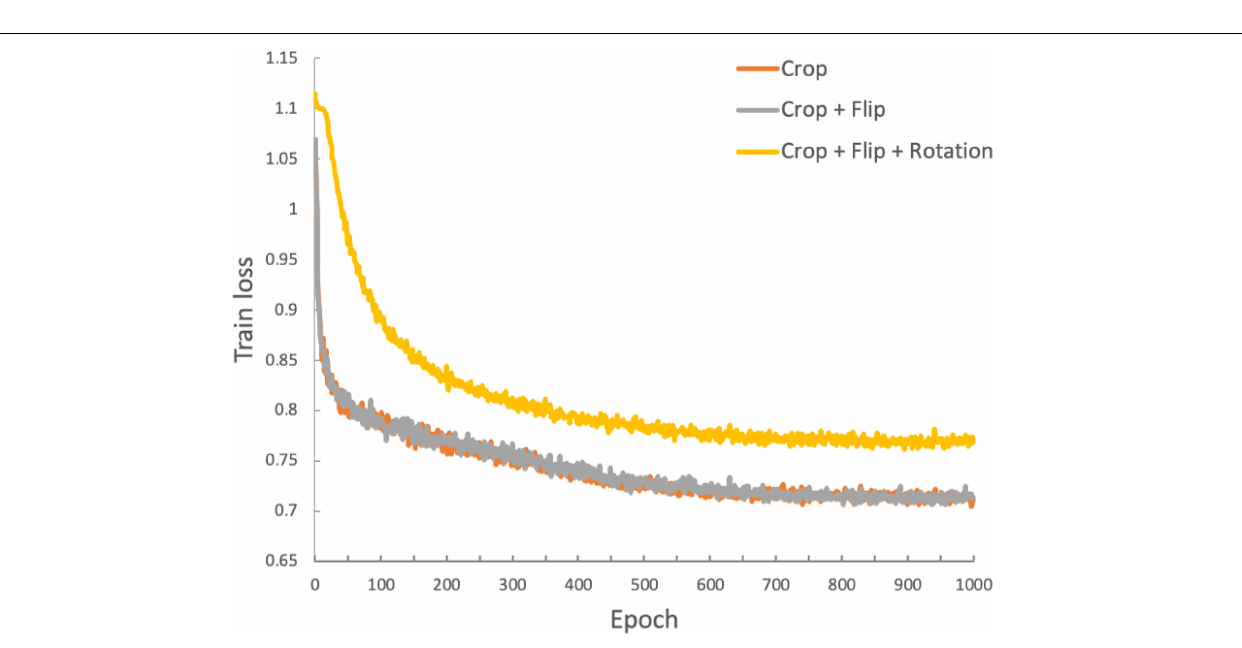
FIGURE 3 | Training loss function for the duration of the training process (1,000 epochs). The three traces represent the loss functions obtained with the three data augmentation strategies: orange: crop only; gray: crop and flip; yellow: crop, flip and rotation.